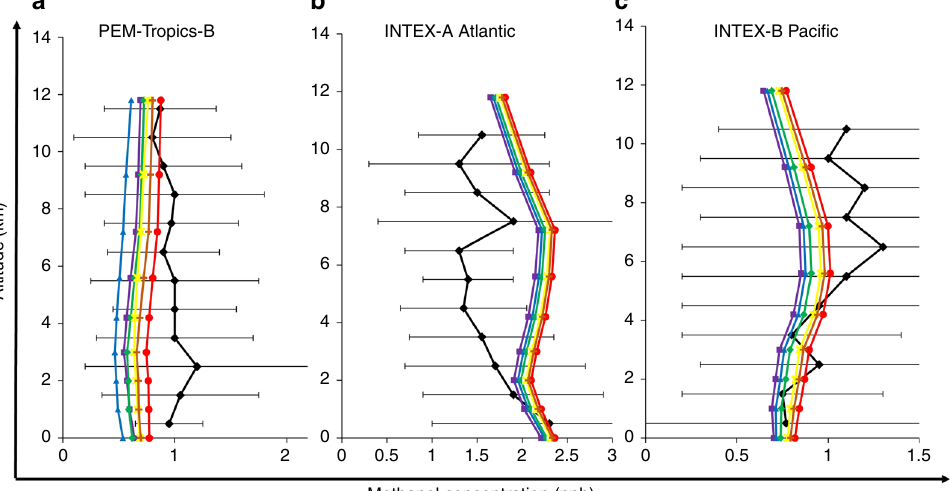
Fig. 6 Comparison of methanol fi eld measurements with modelled outcomes as a function of altitude. Vertical pro fi les of measured and modelled CH 3 OH over a tropical Paci fi c b midlatitude Atlantic and c Paci fi c. The data compilation of Müller et al. 18 containing measured CH 3 OH are used for the model- measurement comparison. Violet square symbols represent mean CH 3 OH produced for the base case (without the OH + CH 3 OO reaction). Blue triangle, green diamond, yellow star, orange plus and red circle symbols represent mean CH 3 OH produced at the branching fractions of the channel of 0.07, 0.1, 0.15, 0.17 and 0.2, respectively. Black triangles represent the measurement CH 3 OH data and the black error bars represent measurement variability (standard deviation)